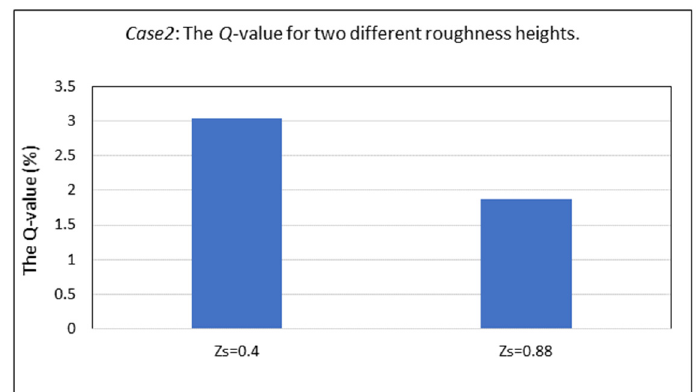
Figure 10. Case 2: Comparison of the Q-value (Equation (2)), i.e., of the average MAPEs over all parameters and over all locations for the CFX simulations using two different values of the roughness parameter Z s . The two values are Z s = 0.4 m and Zs = 0.88 m. Best results were obtained with Zs = 0.88 m.